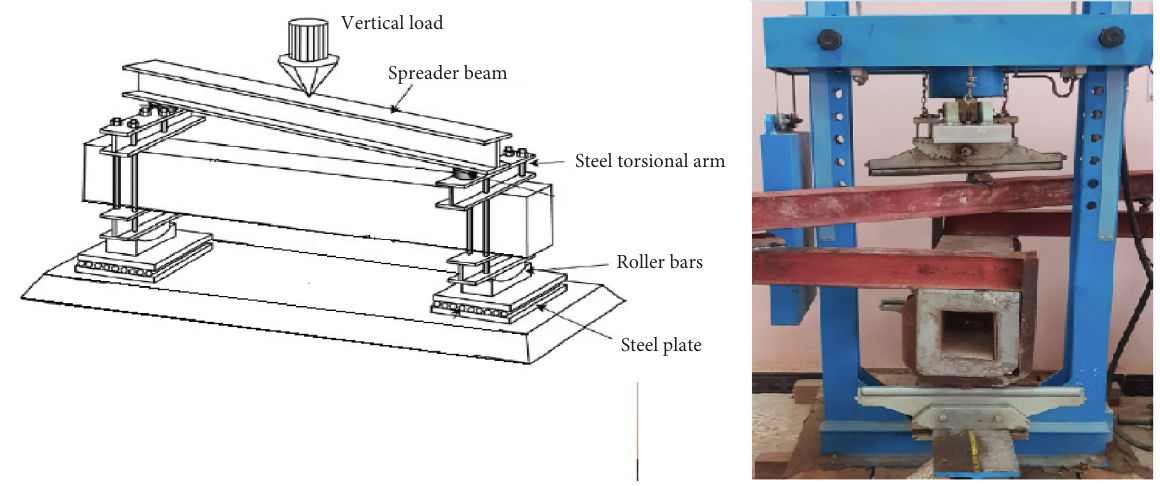
Figure 3: Testing setup.